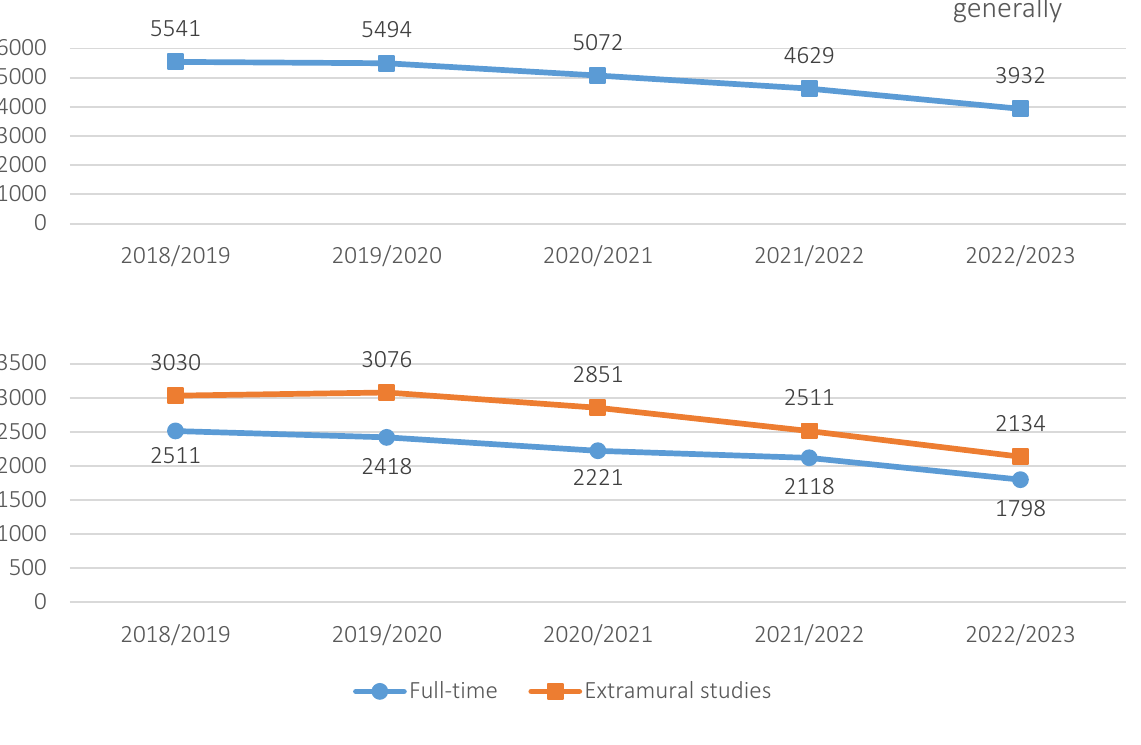
Figure 2. Contingent of university